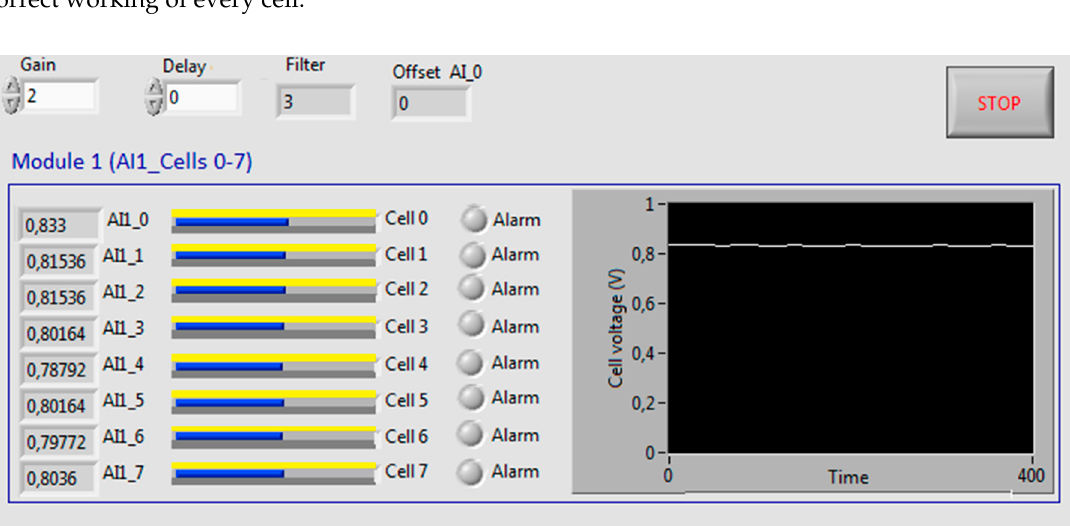
Figure 12. GUI during open circuit test.